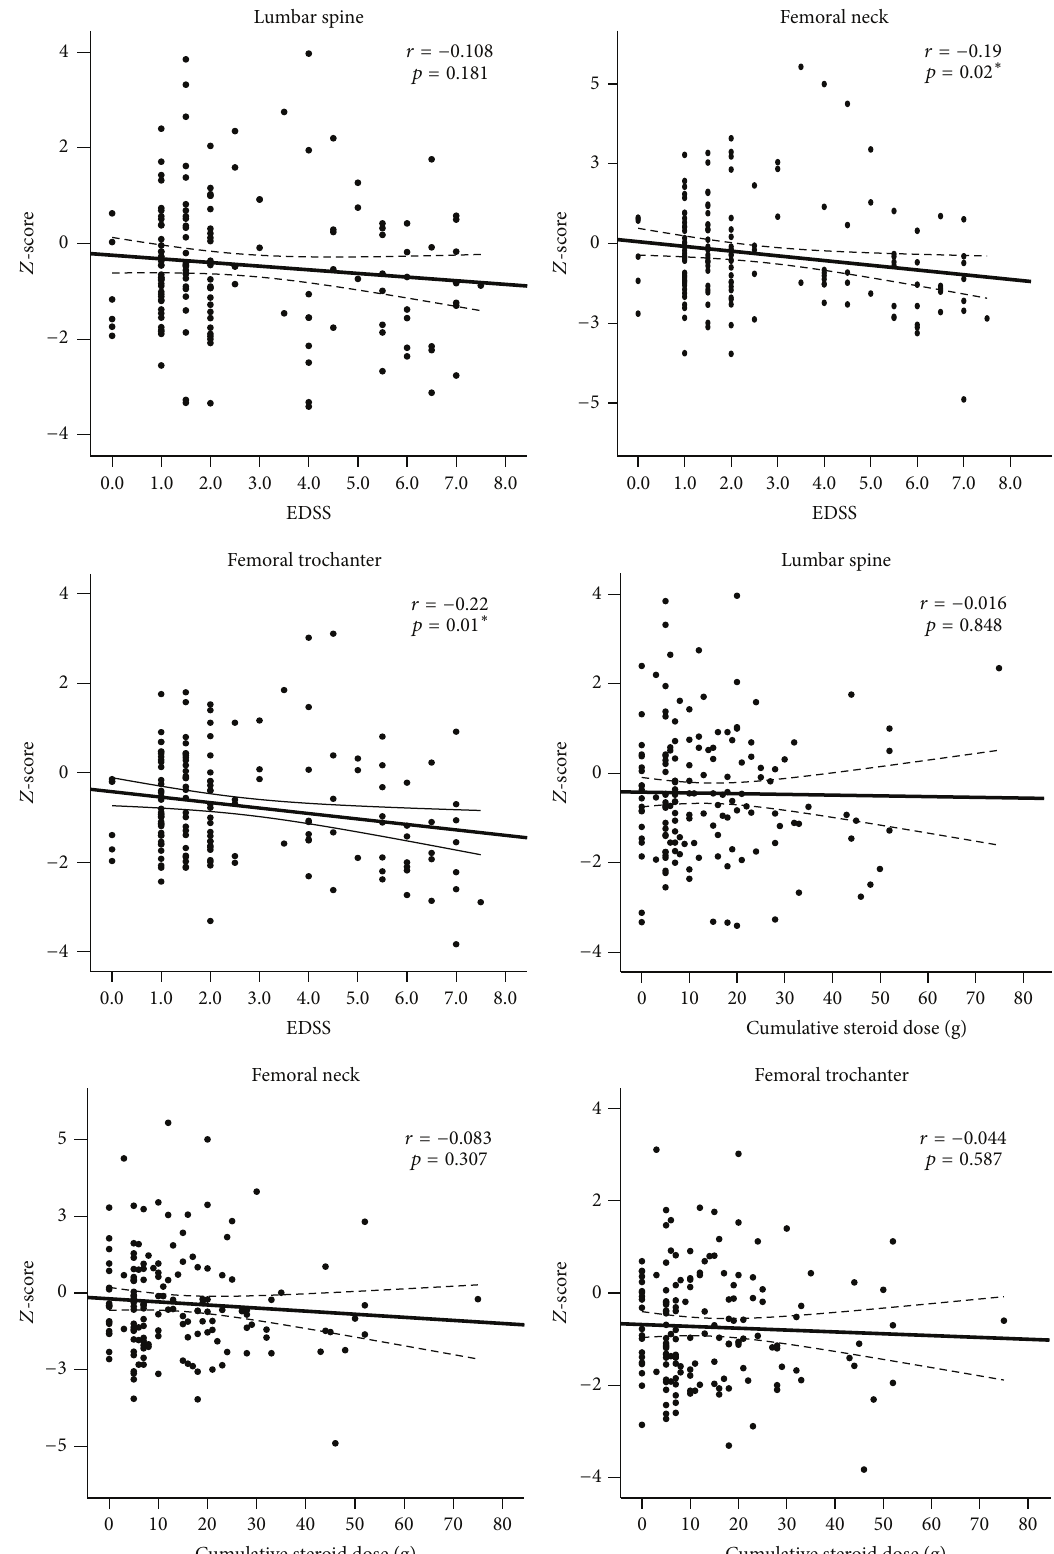
Figure 2: Associations between bone 𝑍 -scores with EDSS scores or cumulative steroid dose. Least-squares lines and 95% confidence interval are shown. ∗ indicates that correlation is significant at the 0.05 level